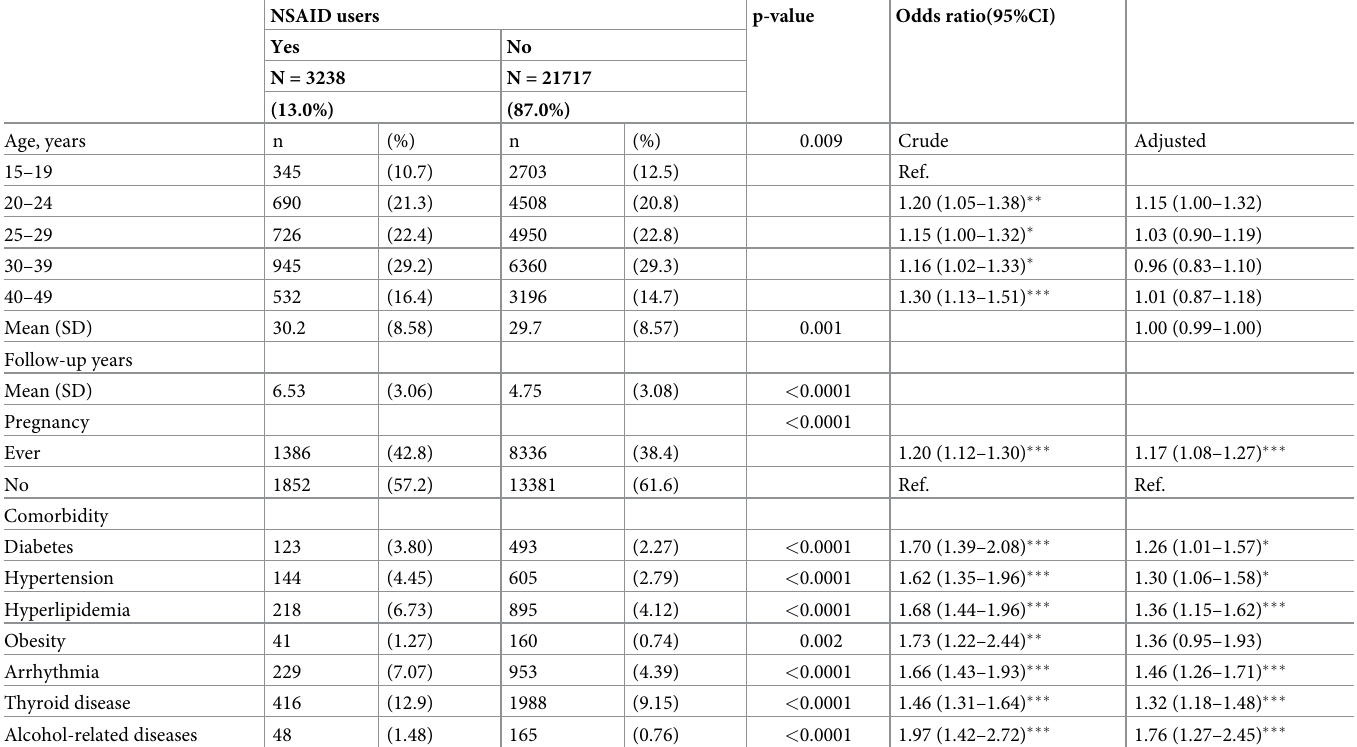
Table 1. Baseline comparison in women with dysmenorrhea, with and without NSAIDs